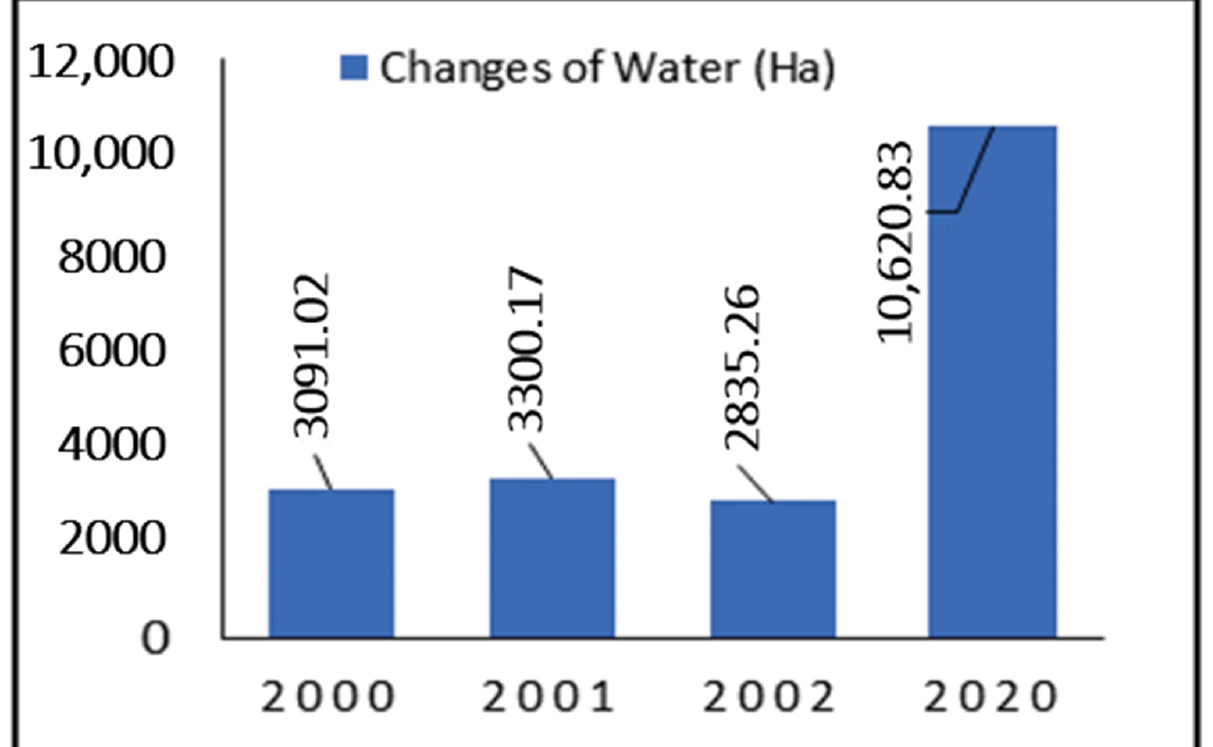
Figure 2. Water surface area changes (ha).